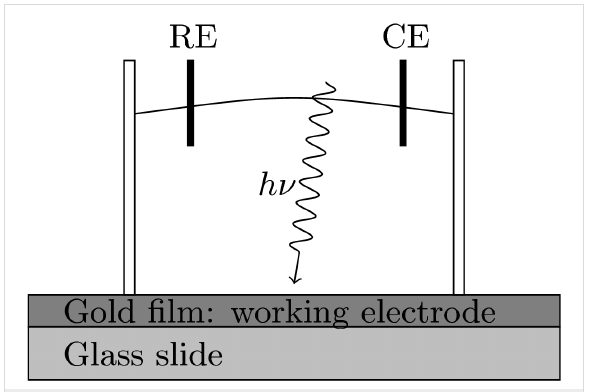
Figure 13: Diagram of an electrochemical cell used for studying the influence of laser illumination on the charge transport at solid–liquid